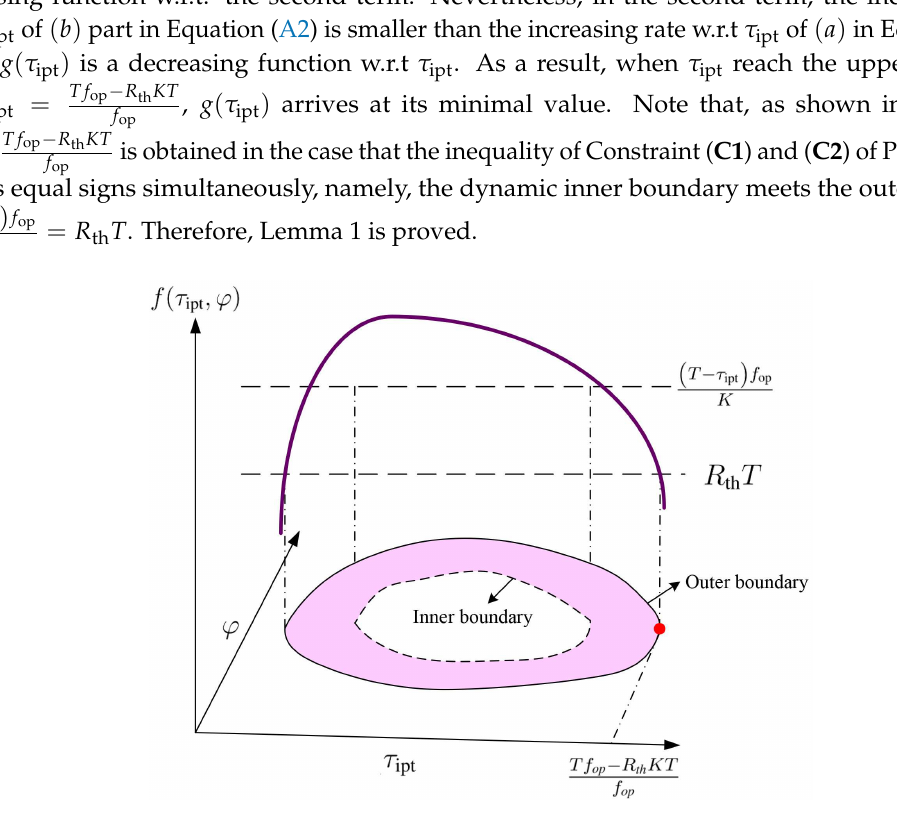
Figure A1. Illustration of the feasible solution